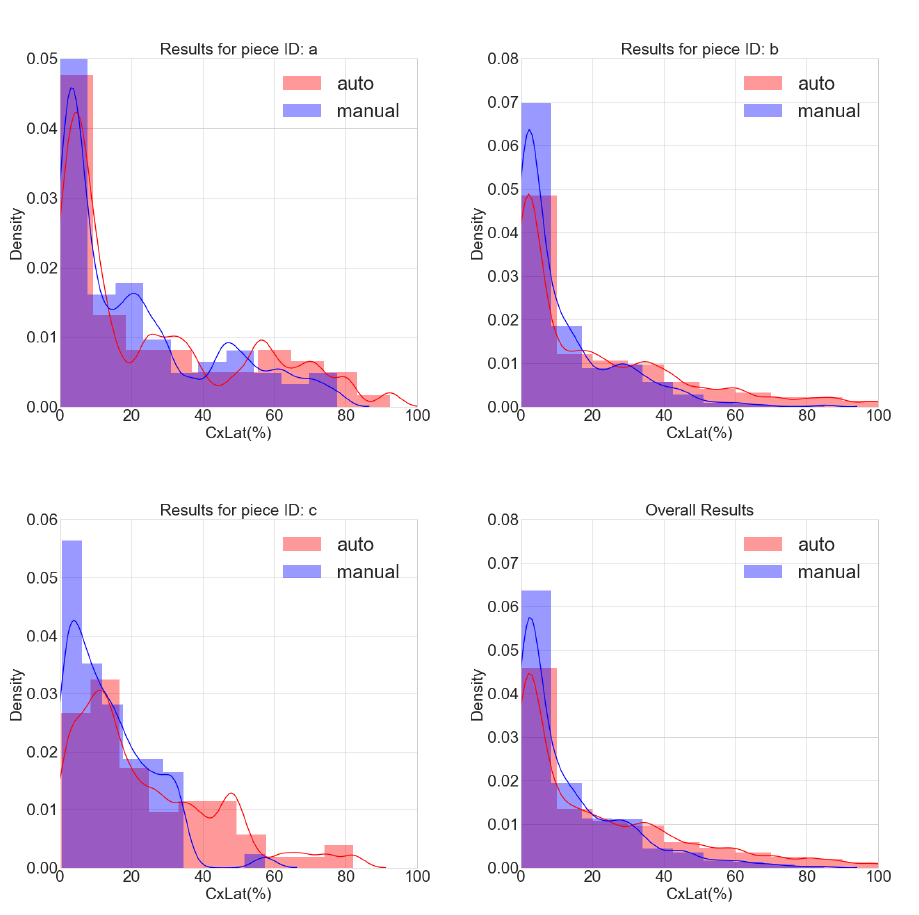
Figure 12. Histograms and density plots for C lat computed for images a ( top left ), b ( top right ) and c ( bottom left ), as well as for pooled data from the three images ( bottom right ), both from automatic (red) and manual (blue) CM masks.